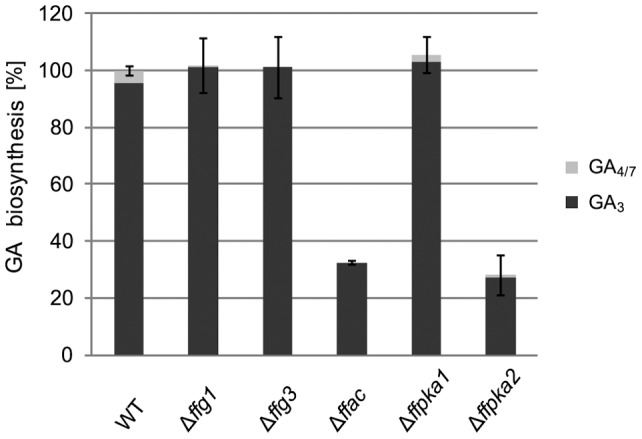
Gibberellic acid (GA) content of cAMP pathway mutants compared to WT.The WT and cAMP pathway mutants (Δffg1, Δffg3, Δffac, Δffpka1, Δffpka2) were grown for 7 days in synthetic ICI medium under GA biosynthesis-favoring conditions (6 mM glutamine). GA3 and GA4/7 were extracted from 20 ml liquid culture (for details see material and methods). For comparison, GA content produced by the WT was set to 100%. Experiments were performed in triplicate.